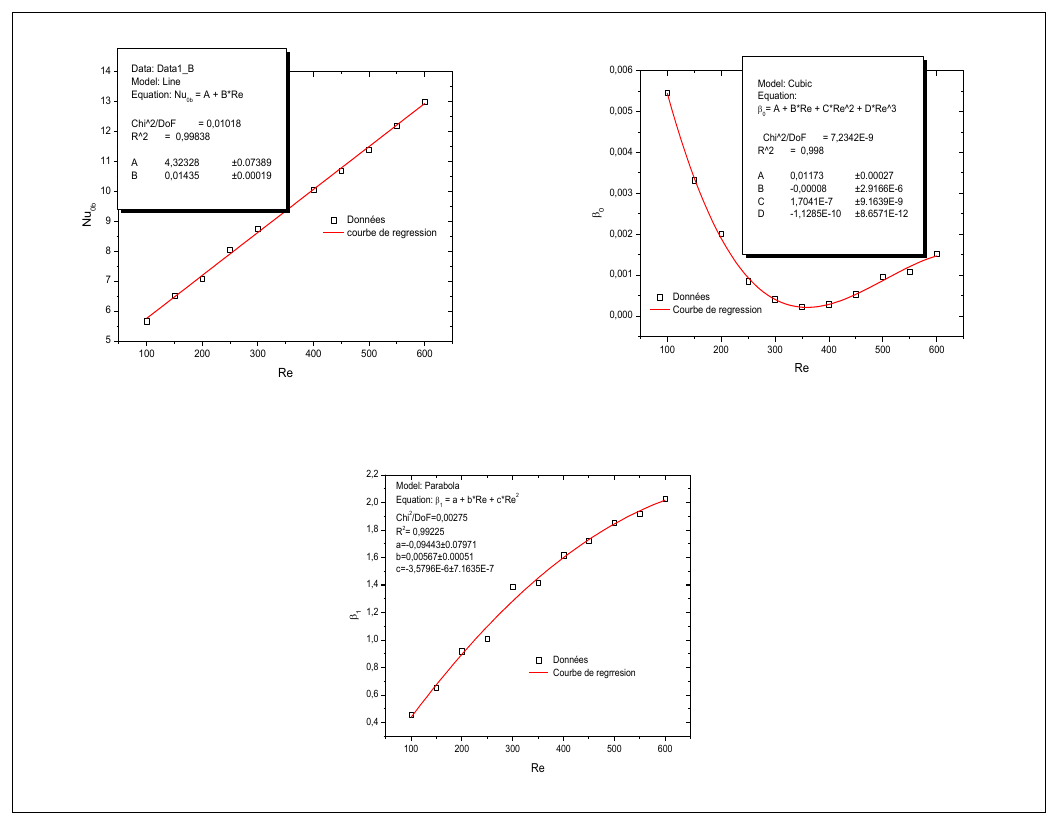
Figure 9 . Regression curves of the coefficients as a function of the Reynolds